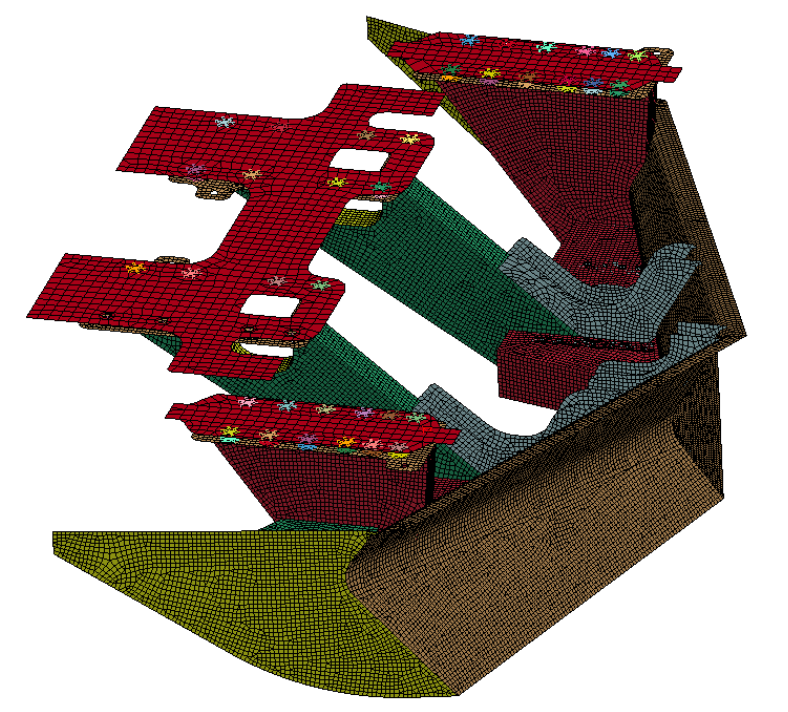
Figure 18. Finite element model of the